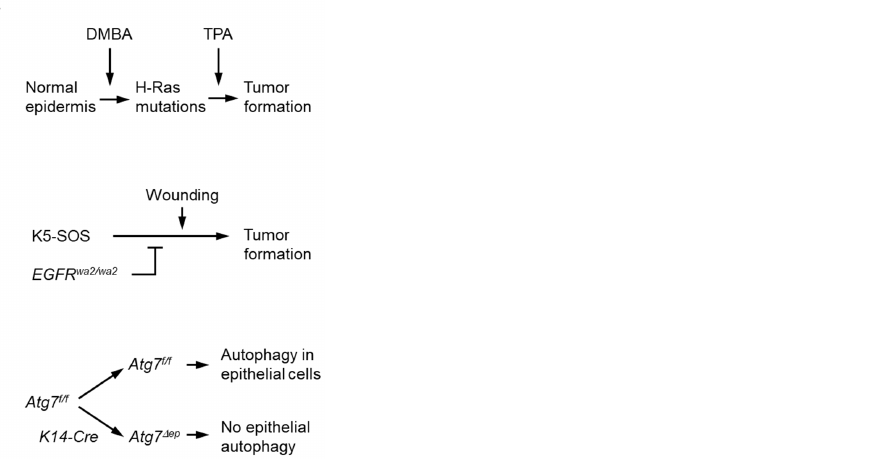
cells of the skin of K14-Cre Atg7 f/f (also referred to as Atg7 Δ ep ) mice. 2. Materials and Methods 2.1. Animals The generation of K14-Cre Atg7 f/f ( Atg7 ∆ ep ) mice and the absence of aberrant inflam- mation in the skin and other organs, as well as the normal body mass of these mice, have been previously reported [24,25]. Tumors were induced in these mice by using the classi- cal two-stage chemical carcinogenesis model (see below). To provide a second tumor model, Atg7 ∆ ep mice and the corresponding K14-Cre -negative Atg7 f/f controls were crossed to K5-SOS EGFR wa2/wa2 mice [22], to yield mice homozygous for EGFR wa2/wa2 and Atg7 f/f and hemizygous for K5-SOS and the K14-Cre transgene. K5-SOS EGFR wa2/wa2 mice develop tu- mors spontaneously at low frequency, and the incidence can be increased through wound- ing [22]. The mice were kept on a normal cycle of 12 h alternating light and dark and allowed access to fodder and water ad libitum. Animal experiments were conducted ac- cording to the guidelines of the Declaration of Helsinki and approved by the Ethics Re- view Committee for Animal Experimentation of the Medical University of Vienna, Aus- tria, and the Bundesministerium für Wissenschaft und Forschung, Austria (protocol: GZ 66.009/0120-II10b/2010, 02.04.2010). 2.2. Chemical Carcinogenesis Model Chemical carcinogenesis was performed in K14-Cre Atg7 f/f females ( n = 17, 8–12 weeks old) and control Atg7 f/f females ( n = 20, 8–12 weeks old). The mice were shaved on their